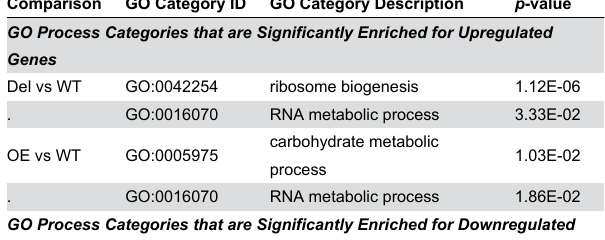
Table 1. The List of GOSlim Categories That Are Significantly Enriched For Differentially Expressed Genes Between The veA Deletion (Del) And The Wild-Type (WT) Strain As Well As Between The veA Overexpression (OE) And The WT Strain.